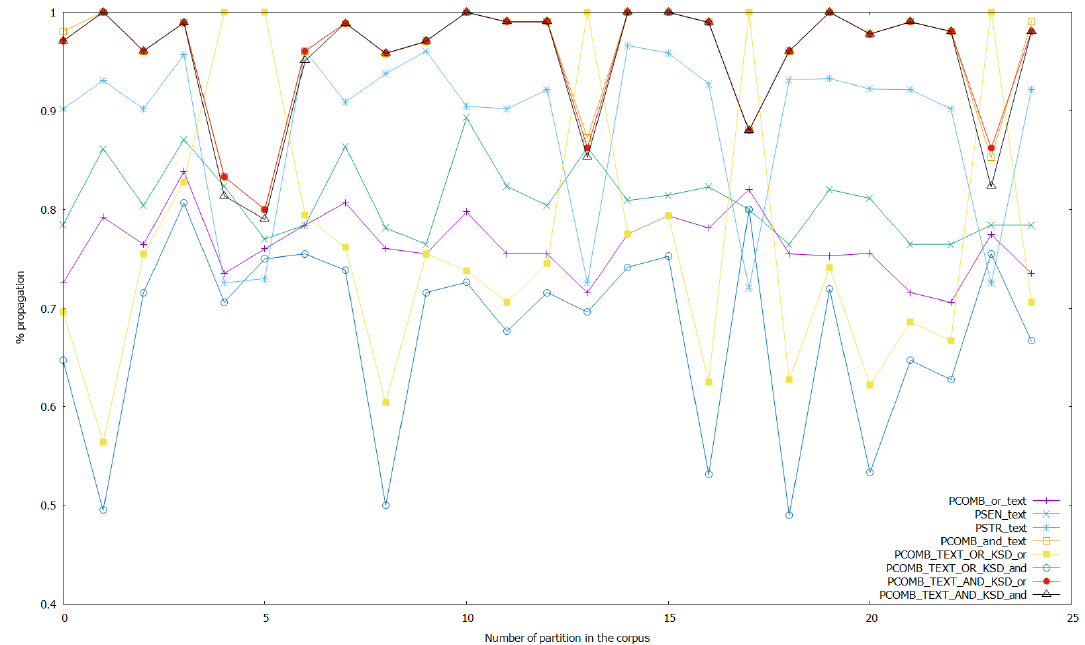
Figure 10. Results of the experiments with the sentiment, stress, and combined analyses on text, and with the combined analyses on text and keystroke data with threshold set to 0.7 in the ANNs that perform sentiment analysis.